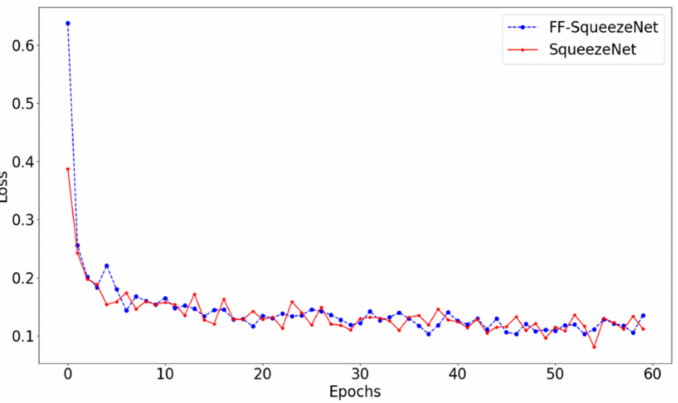
Figure 11. Loss curves of the original SqueezeNet and our FF-SqueezeNet.